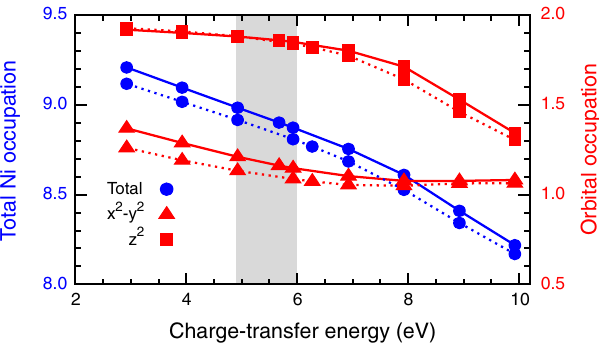
FIG. 4. The DMFT occupation of x 2 − y 2 (red, square) and 3 z 2 − r 2 (red, triangle) orbitals and the entire Ni 3 d shell (blue, circle) as a function of Δ and the dashed line for Nd 0